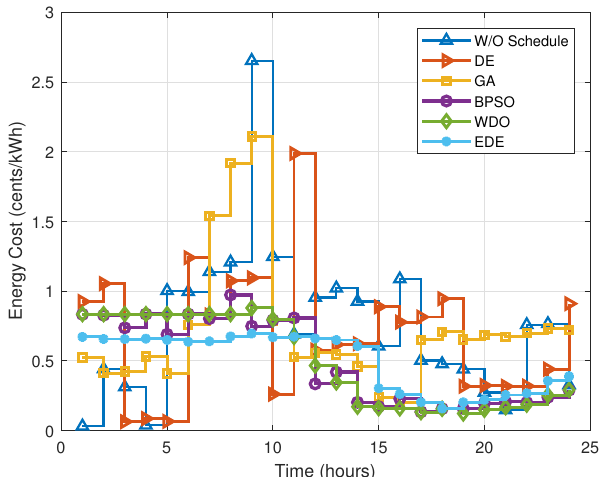
Figure 14. Energy cost per hour evaluation after scheduling noninterruptible